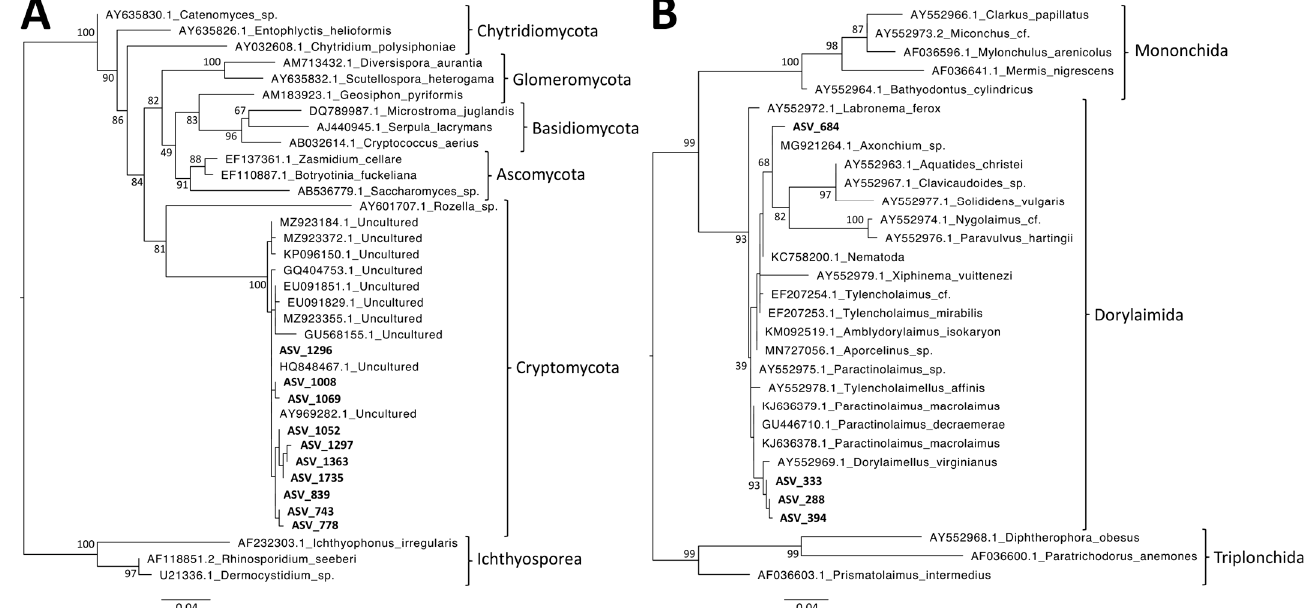
Figure 8. Maximum-likelihood phylogenetic trees. Numbers are ultrafast bootstraps (%) of the main nodes. ASV: amplicon sequence variant. ( A ) Significant Cryptomycota ASVs. The tree was rooted using Ichthyosporea. The ASVs used in this figure were all significantly associated with Miconia calvescens . ( B ) Significant Dorylaimida ASVs. The tree was rooted using Triplonchida. ASV_684 was significantly associated with MIC. ASV_288, ASV_333, and ASV_394 were significantly associated with both Miconia calvescens and Spathodea campanulata .